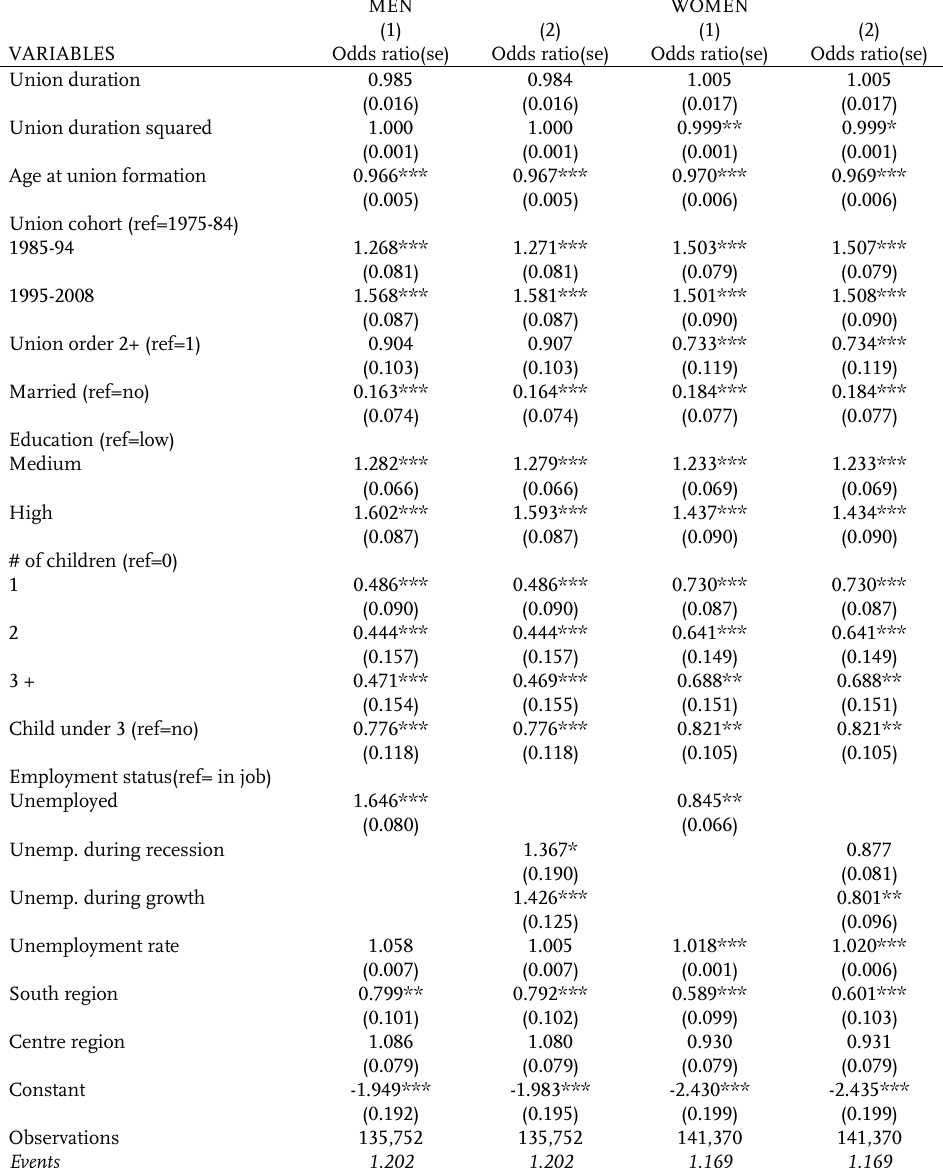
Table A.5 : Discrete time model, full results by country: